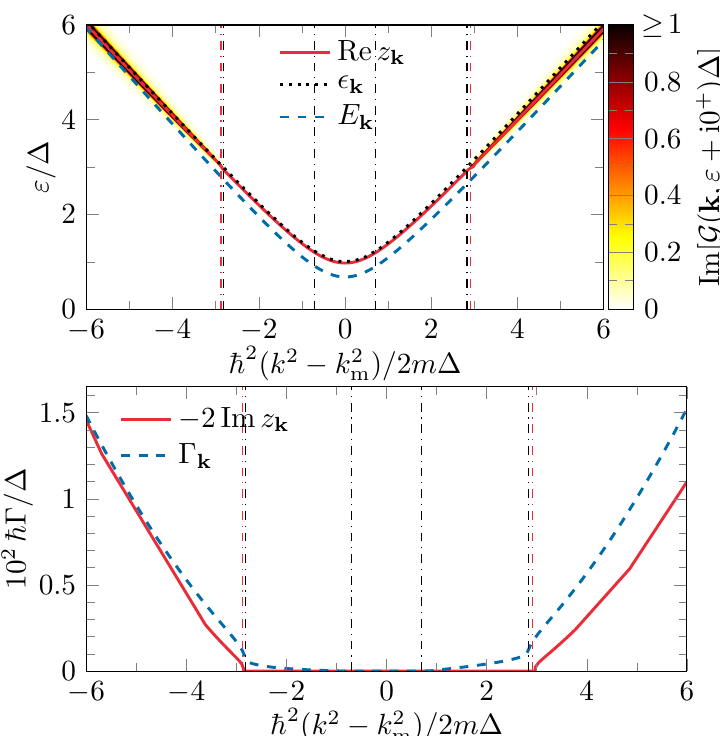
a (cid:39) − 3). Figure 11: Quasiparticle spectrum in the BCS regime ( µ/ ∆ = 100, 1 / k F The eigenenergies and spectral density are shifted to facilitate the comparison be- tween the different curves. The self-consistent solution is shown in red, and both its real (top panel) and imaginary part (bottom panel) are shifted with respect to k ∗ m computed from z . The perturbative result (blue dashed line) incorrectly predicts a k finite quasiparticle lifetime at the dispersion minimum, but to be able to compare with the self-consistent result, the real part E is shifted with respect to k ∗ , while k m the damping rate Γ is shifted to k ( 0 ) . The black dotted line is the mean-field energy, k m and the vertical dash-dotted lines depict the shifted k -values where the mean-field energy ε and self-consistent energy z cross the threshold energies respectively in k k black and